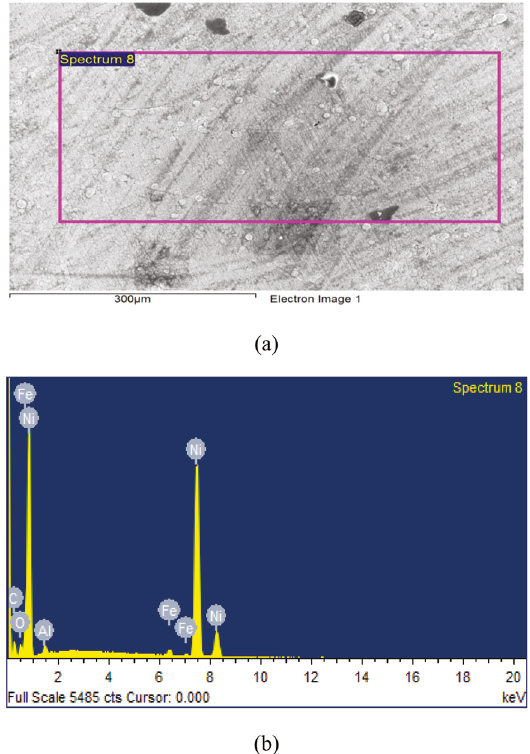
O composites of 2 3